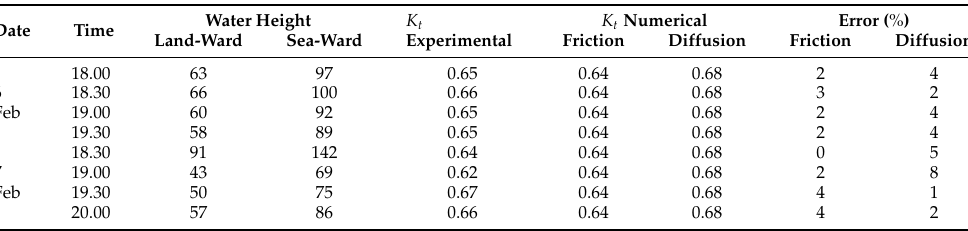
Table 1. Comparison between the Transmission Coefficient K t obtained using Experimental and Numerical